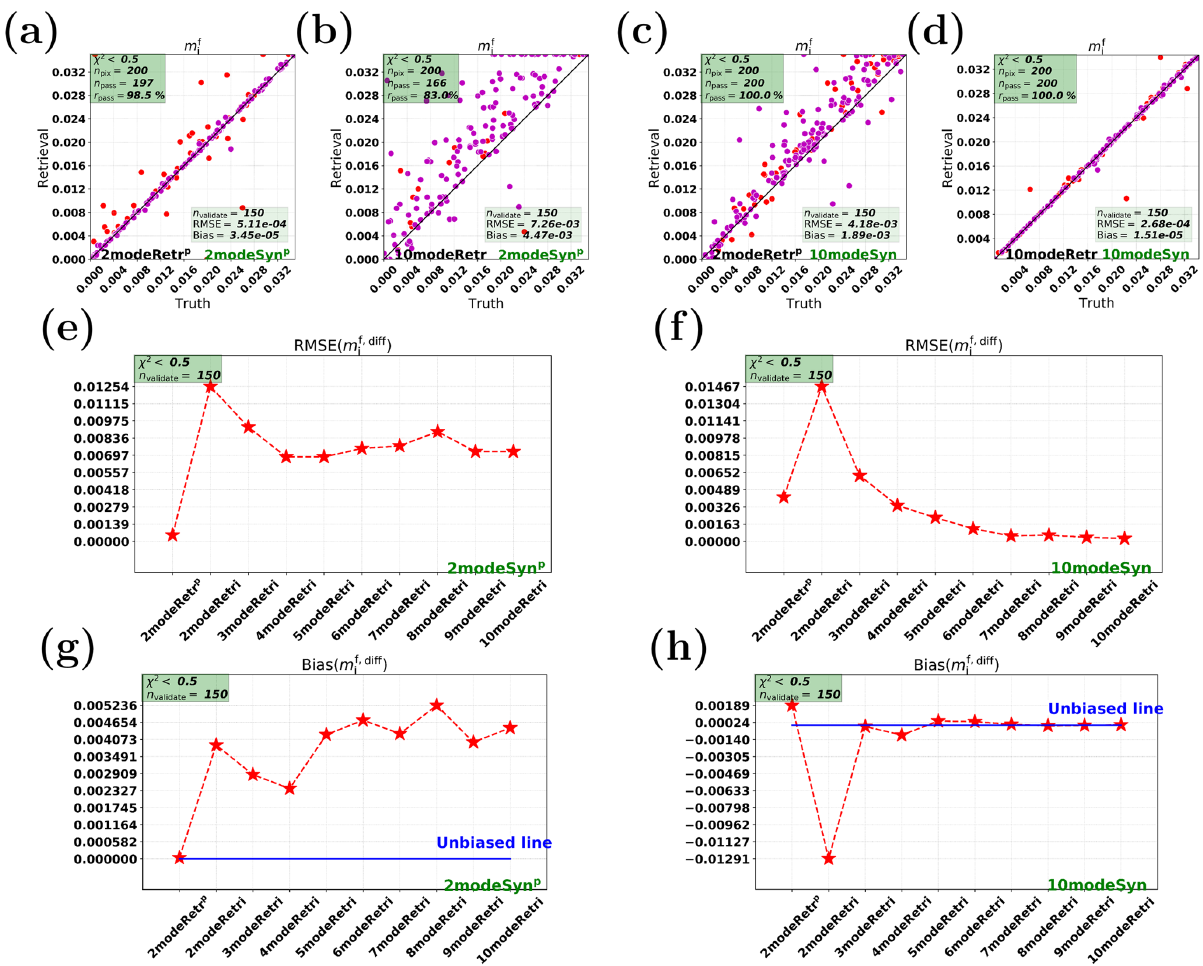
Figure 9. Synthetic retrievals for the imaginary part of refractive index (at 550nm) of the fine modes ( m f h) show cases on 2modeSyn p and 10modeSyn,